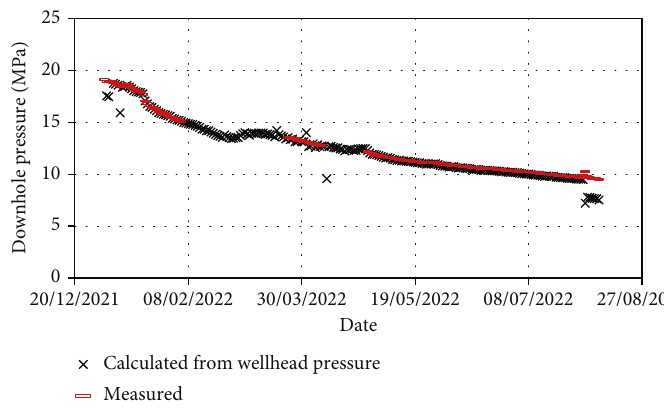
Figure 7: Variation of downhole pressure with the development time of Well